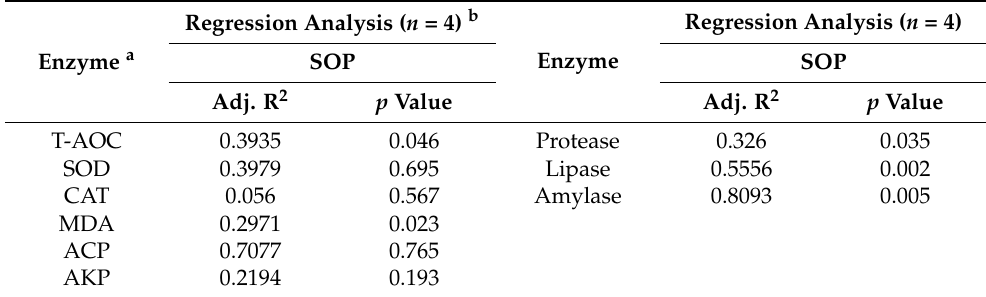
Figure 2. Effects of different doses of β -glucan on the ( A ) protease, ( B ) lipase and ( C ) amylase enzyme activities in Juvenile L. vannamei . Different letters indicate significant differences ( p < 0.05) among groups. All data are expressed as the mean ± SE ( n = 4). Table 3. Regression analysis of biochemical assays in the hepatopancreas of Juvenile L. vannamei fed different dietary β -glucan levels.